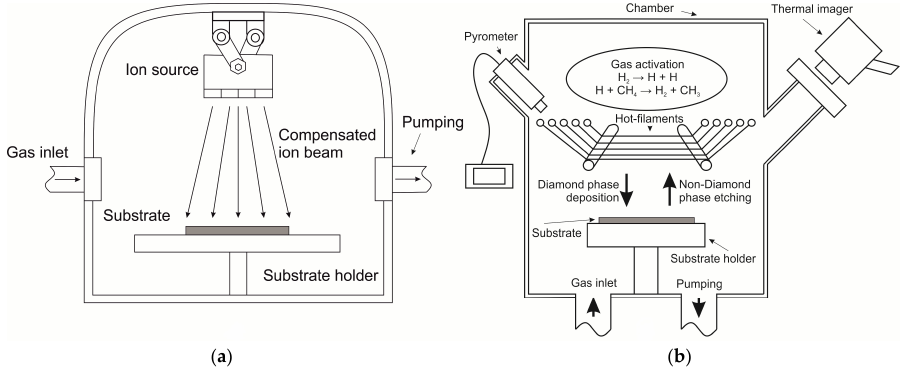
Figure 2. Schematic of ( a ) the reactive ion etching process; ( b ) the HF ‐ CVD reactor.